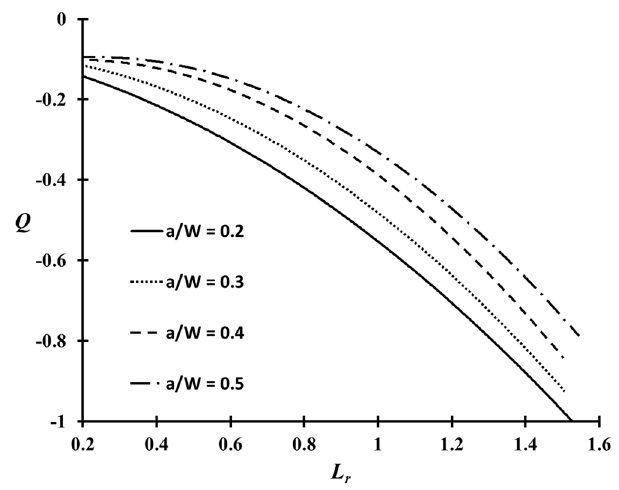
Figure 7. (cid:1843) parameter distributions of the CT specimen for various crack configurations.